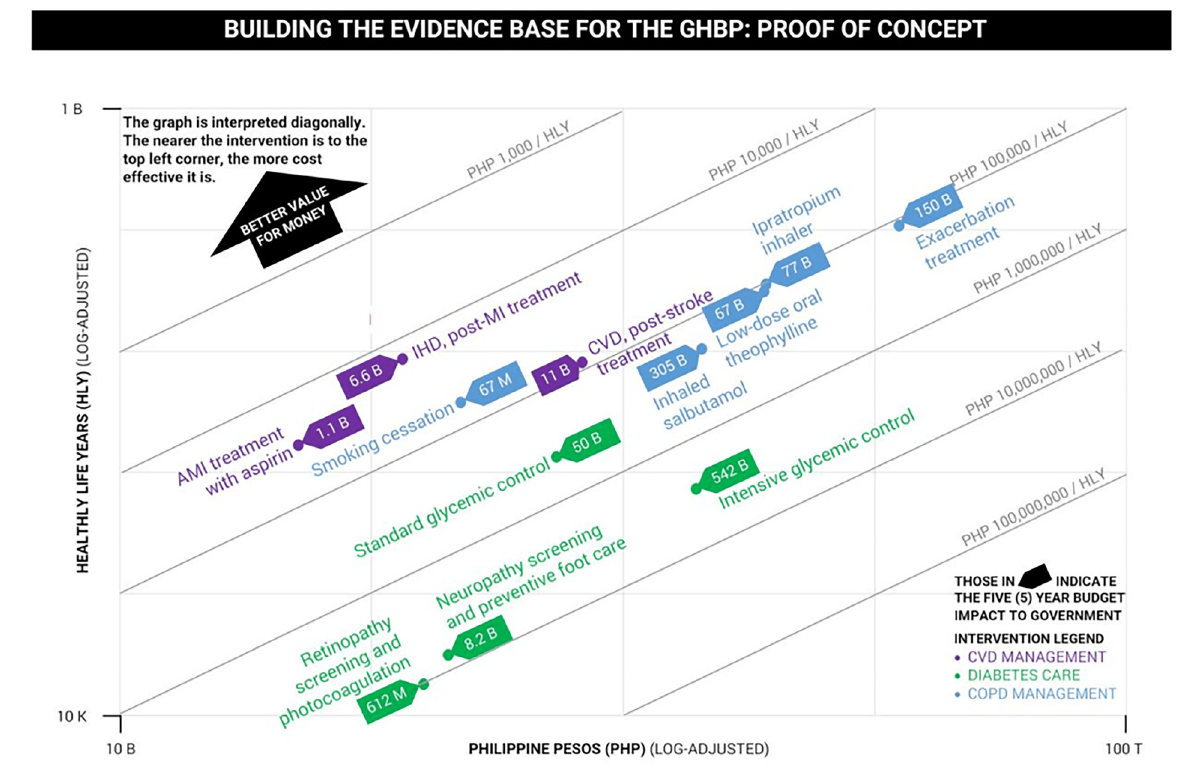
Figure 1. Isoquant graph of selected non-communicable interventions with budget impact price tags. Calculations made using OneHealth Tool.